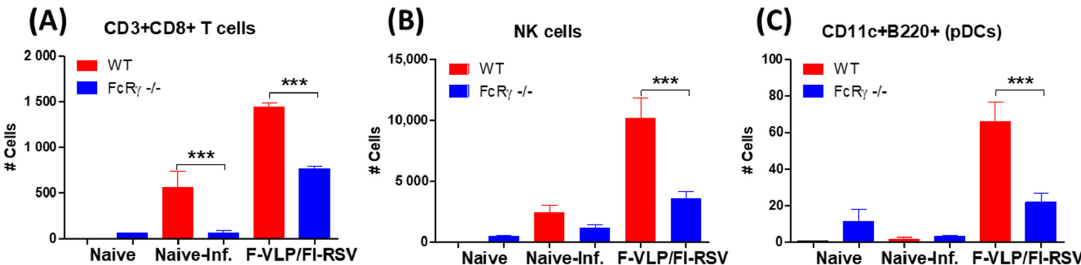
Figure 5. The number of CD8 T-cells, NK cells and plasmacytoid dendritic cells (pDCs) out of the total BAL cells collected per mouse (n = 5 per group). In the bronchoalveolar lavage fluid (BALF) after challenge, BAL cells were harvested, stained with CD45, CD3, CD8, DX5, CD11c, and B220, and analyzed using flow cytometry. ( A ) CD3+CD8+ T-cells, ( B ) DX5+ NK cells, and ( C ) CD11c+B220+ pDCs. Results are presented as mean ± SEM. *** p < 0.001.